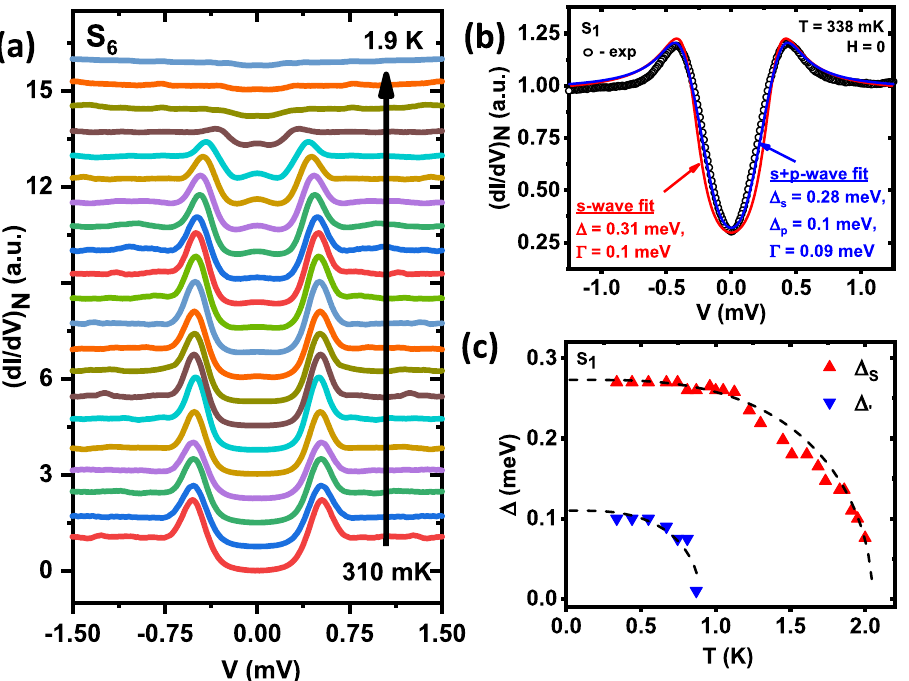
Figure 4. ( a ) Temperature (T) dependence of tunneling conductance spectra S 6 incorporating gradual appearance and disappearance of the peak-like feature. ( b ) Spectrum S 1 along with best pure s -wave (red line) p -wave (blue line) fits with corresponding extracted parameters (cid:31) and Ŵ . ( c ) Evolution of (cid:31) s and and mixed s + (cid:31) p with temperature, extracted from the s p -wave fits of spectra S 1 . Ideal BCS trends of (cid:31) are also shown for +